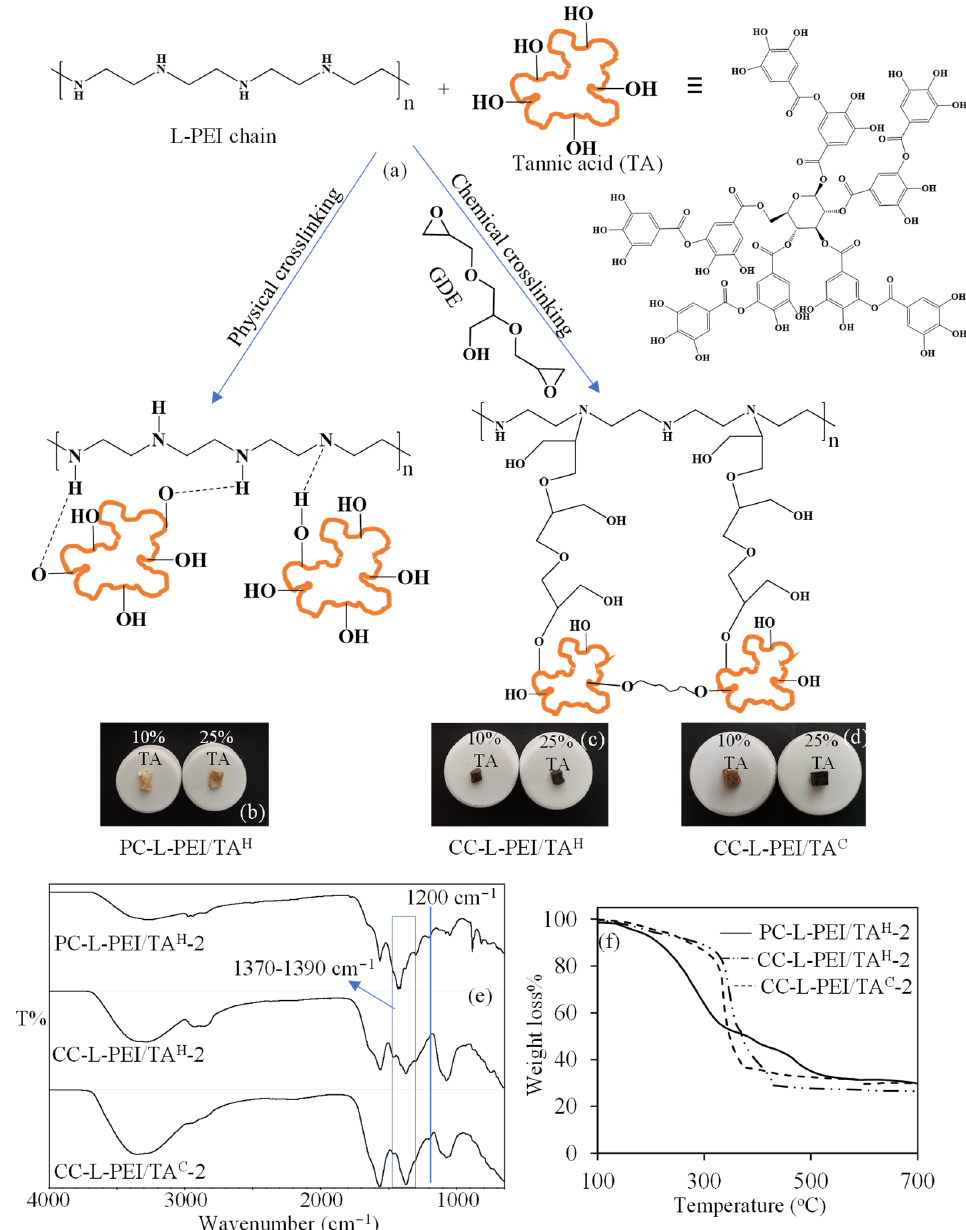
Figure 3. ( a ) the schematic presentation of the synthesis of physically and chemically crosslinked L-PEI/TA networks, digital camera images of 10 and 25% TA containing ( b ) PC-L-PEI/TA H , ( c ) CC-L-PEI/TA H , and ( d ) CC-L-PEI/TA C , and comparisons of ( e ) the FT – IR spectrum, and ( f ) TGA thermograms of L-PEI/TA networks.